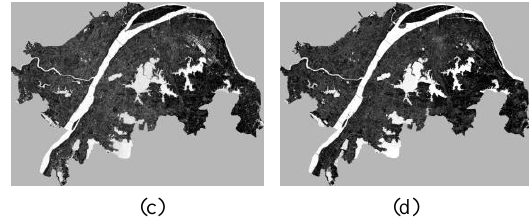
Figure 4. MNDWI images: (a) 1991, (b) 2002, (c) 2011, and (d) 2017.